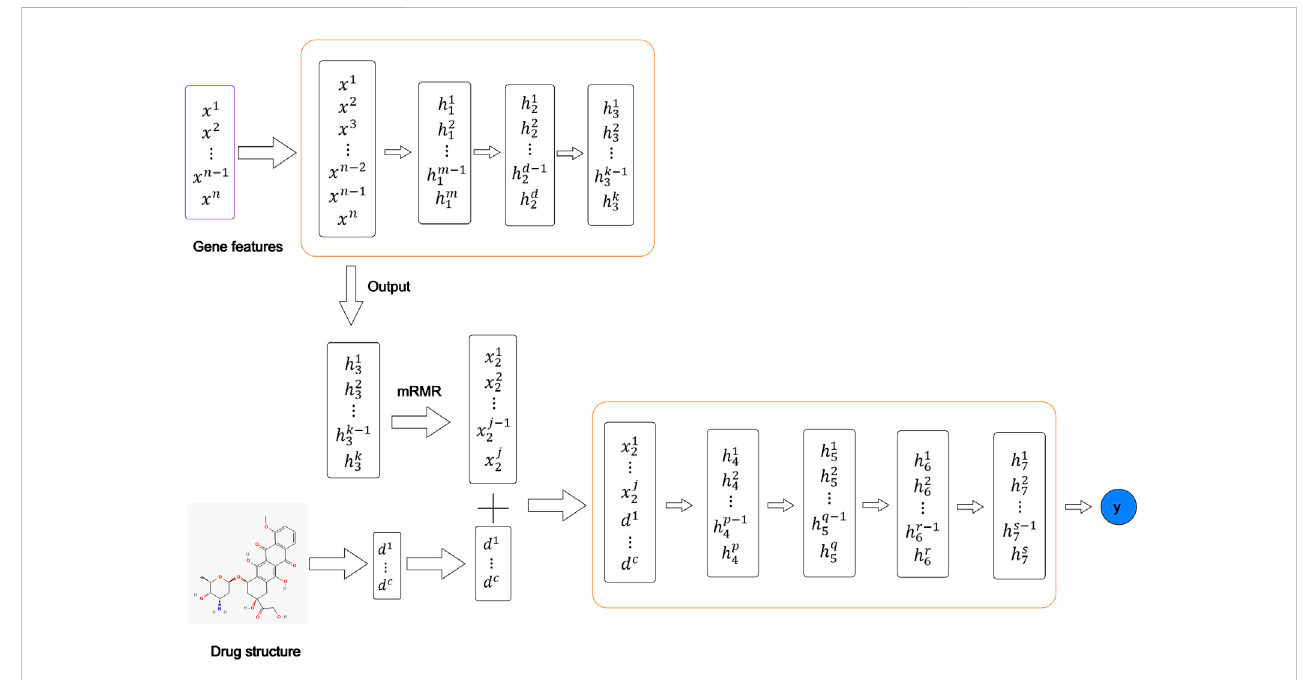
FIGURE 3 ANN structure for drug response prediction.